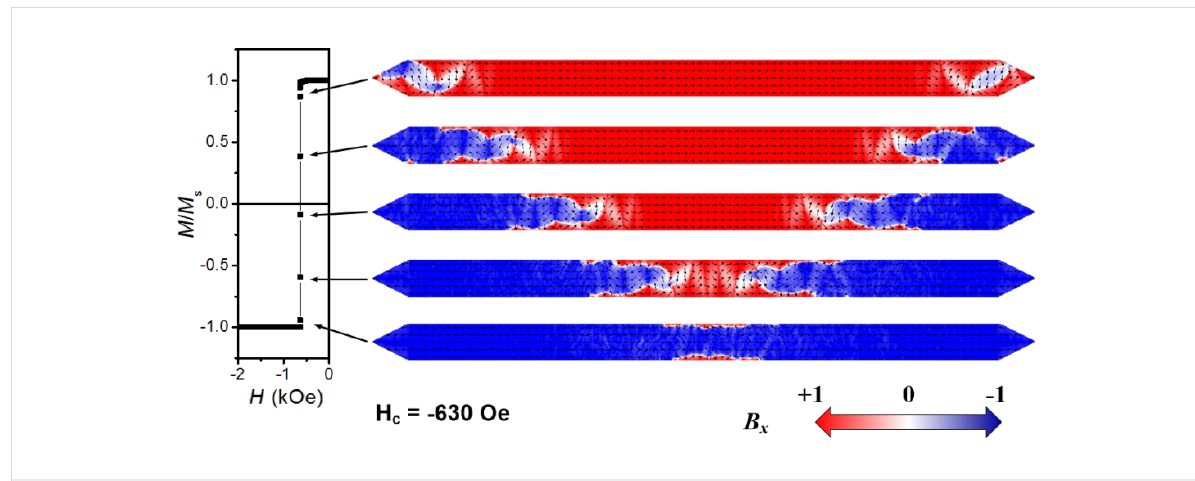
Figure 7: Simulated magnetization reversal with five snapshots of the magnetization state in the nanowire with width of 250 nm, thickness of 20 nm and profile defined as case I.